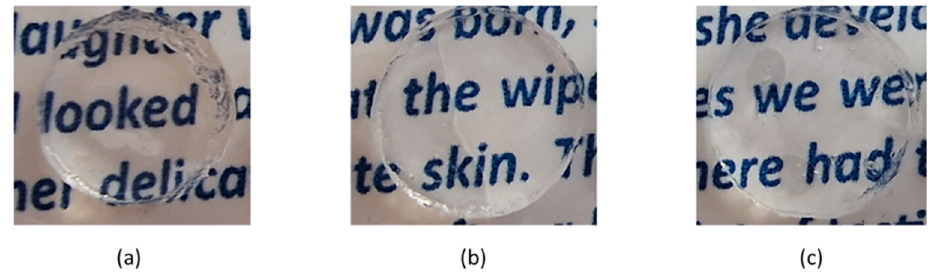
Figure 6. Photographic images of TM-loaded ( a ) SV1-2, ( b ) SV1-1 and ( c ) SV2-1 hydrogels. All hydrogels appeared not to transmit much light in the UV-B region (Figure 5), e.g., their transmittance is between 19 and 28%, depending on their composition, which means Table 5. Optical transmittance of pSB-co-pVP and pSB hydrogels, loaded with TM.